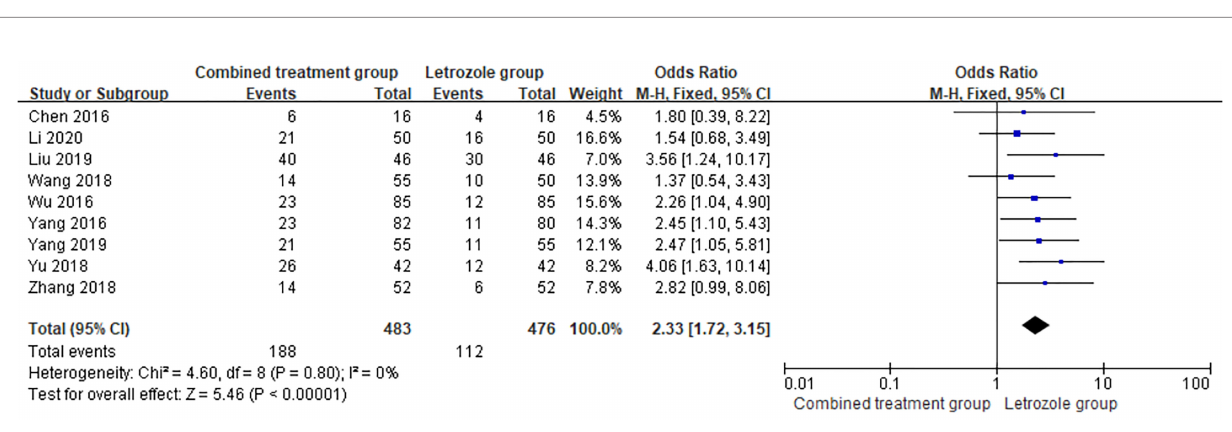
FIGURE 3 | Meta-analysis of the effect of Kuntai capsule combined with letrozole on the pregnancy rate in polycystic ovary syndrome (PCOS).